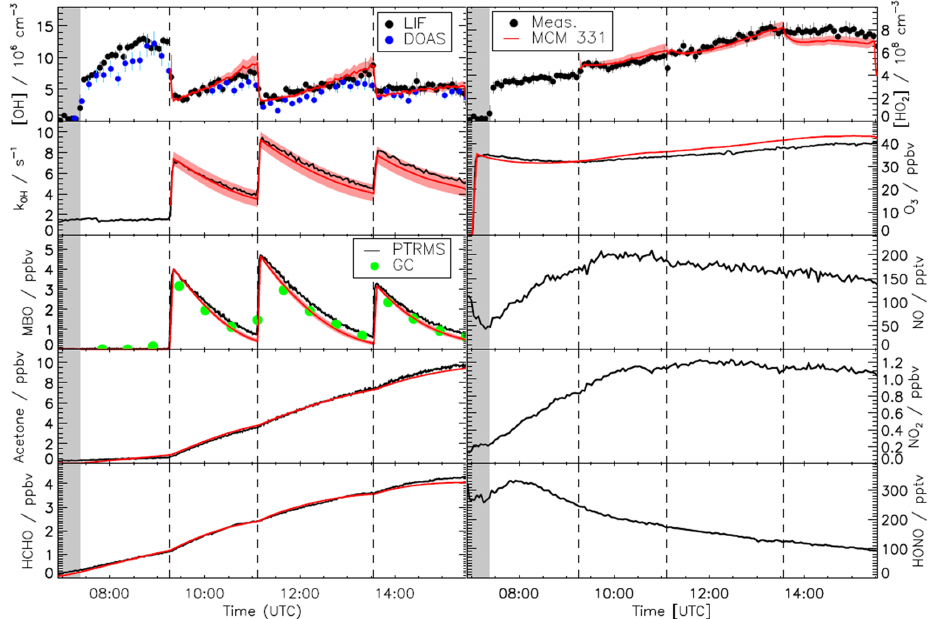
Figure 2. Measured time series of OH, HO 2 , MBO, acetone, formaldehyde, O 3 , trace gases, and OH reactivity compared to results obtained from modelling using the MCM version 3.3.1. There are no model results for NO, NO 2 , or HONO as the model was constrained to the mea- surements. The red shaded areas represent the uncertainty in the model due to the uncertainties of the zero of the OH reactivity measurements (see text for details). Grey shaded areas indicate the times before opening the chamber roof and vertical dashed lines indicate the times when MBO was